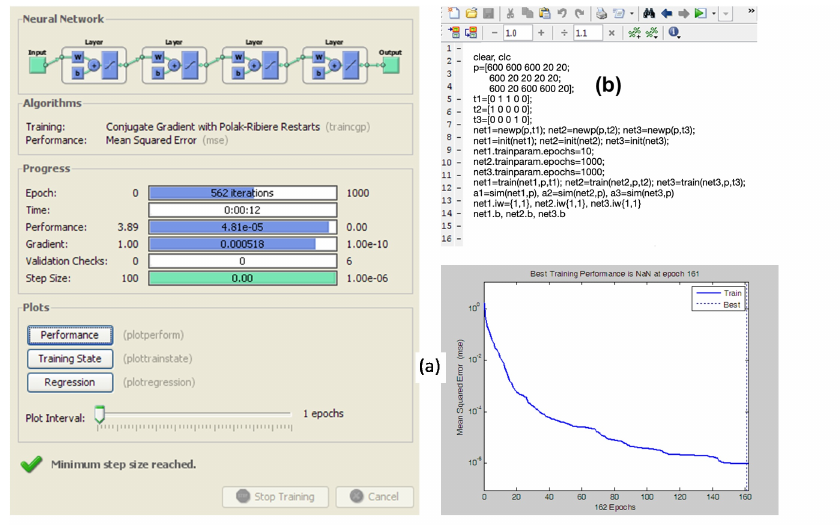
Figure 15. Neural network training